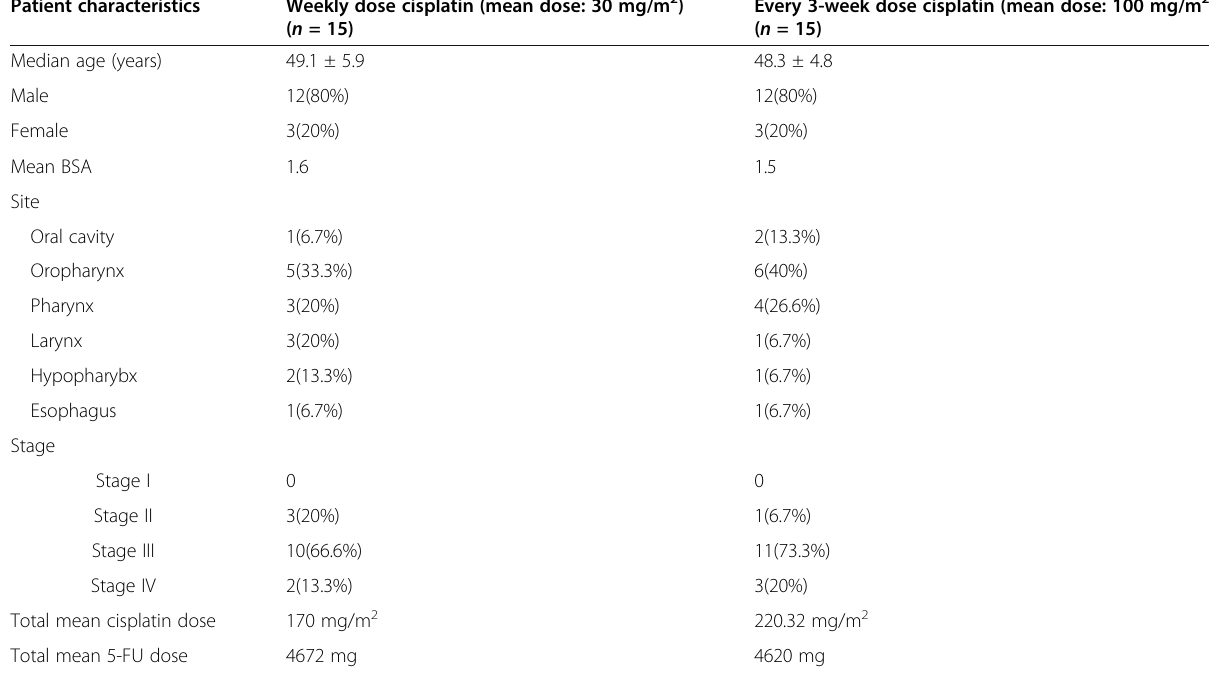
Table 1 Characteristics of LA-SCCHN patients receiving weekly (group A) and every 3-weekly (group B) cisplatin dose Patient characteristics